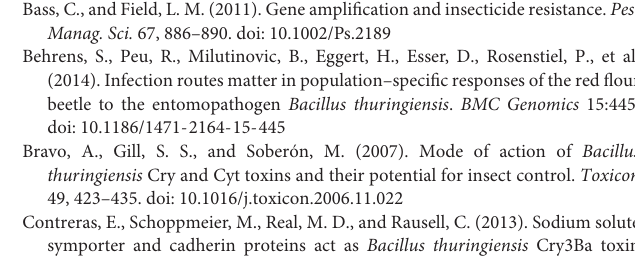
Supplementary Table 1 | Information of primers used in the experiment. Supplementary Table 2 | Correlation coefficient. Supplementary Table 3 | Sequencing data evaluation statistics. Supplementary Table 4 | The shared DEGs were identified in two comparative analysis groups. Supplementary Table 5 | The expression information of